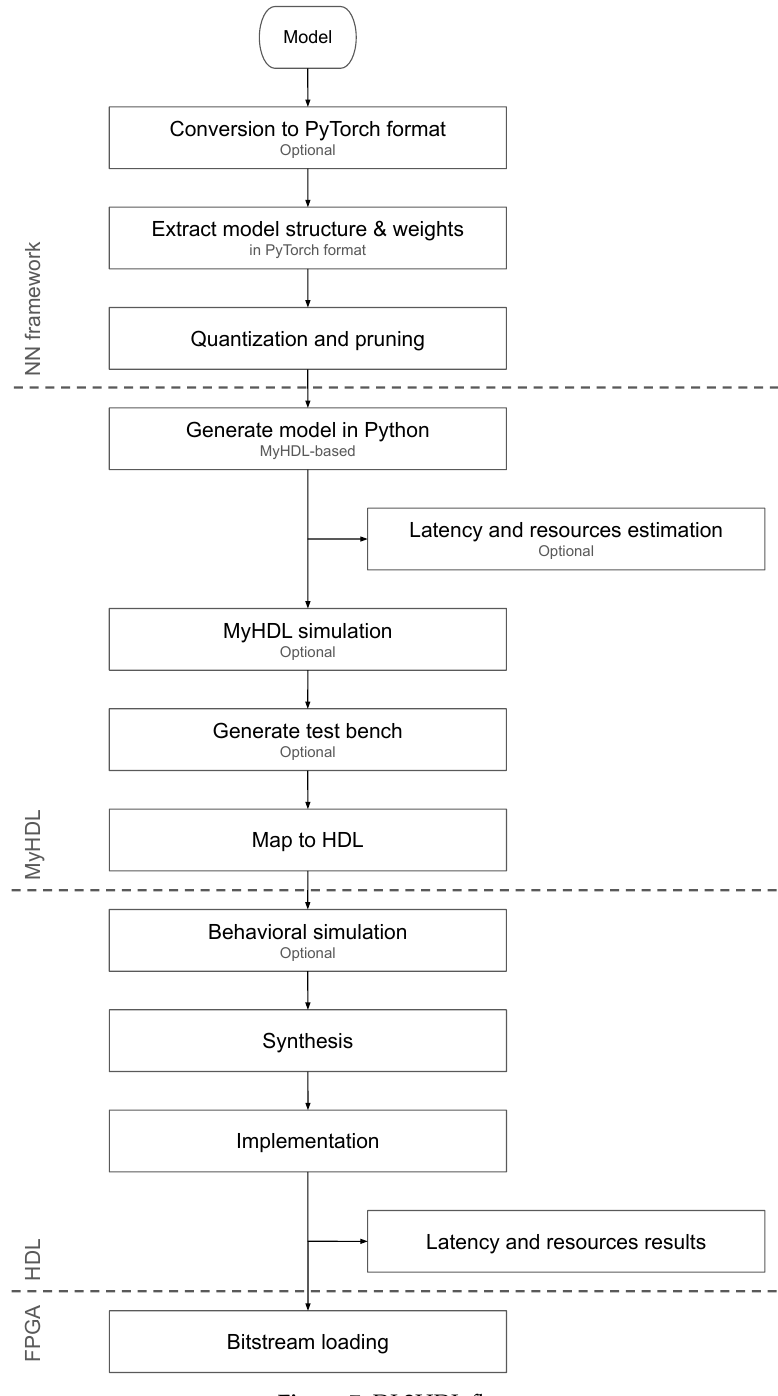
Figure 7. DL2HDL